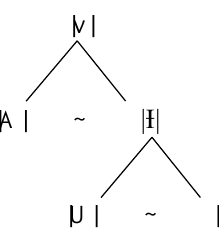
Figure 5 . Subsymbolic hierarchy of vocalic